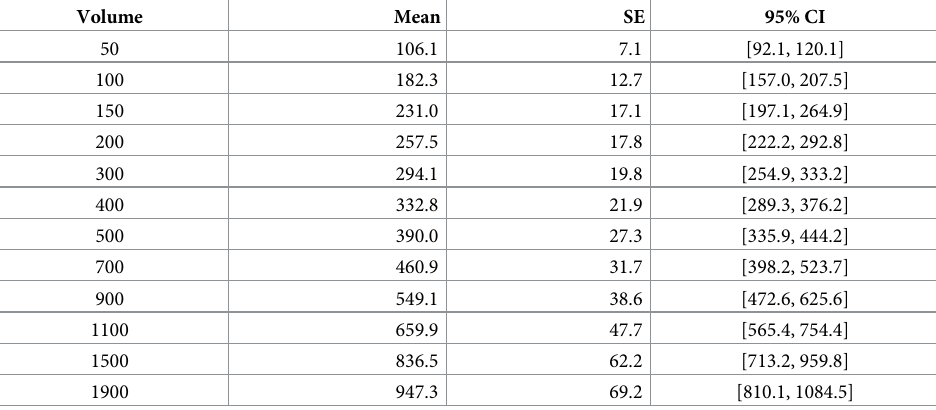
Table 1. Means and 95% confidence intervals for the different volumes of blood